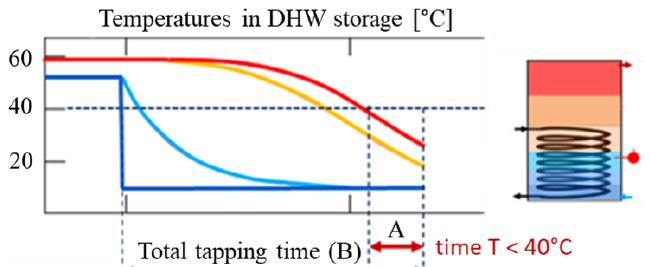
Figure 5. Example of DHW discomfort duration key performance indicator (KPI). The colours refer to the temperature layers of the DHW vessels. This KPI is calculated as A/B, where B is the total tapping time of all end-users and A is the total time at which the DHW temperature is below 40 ◦